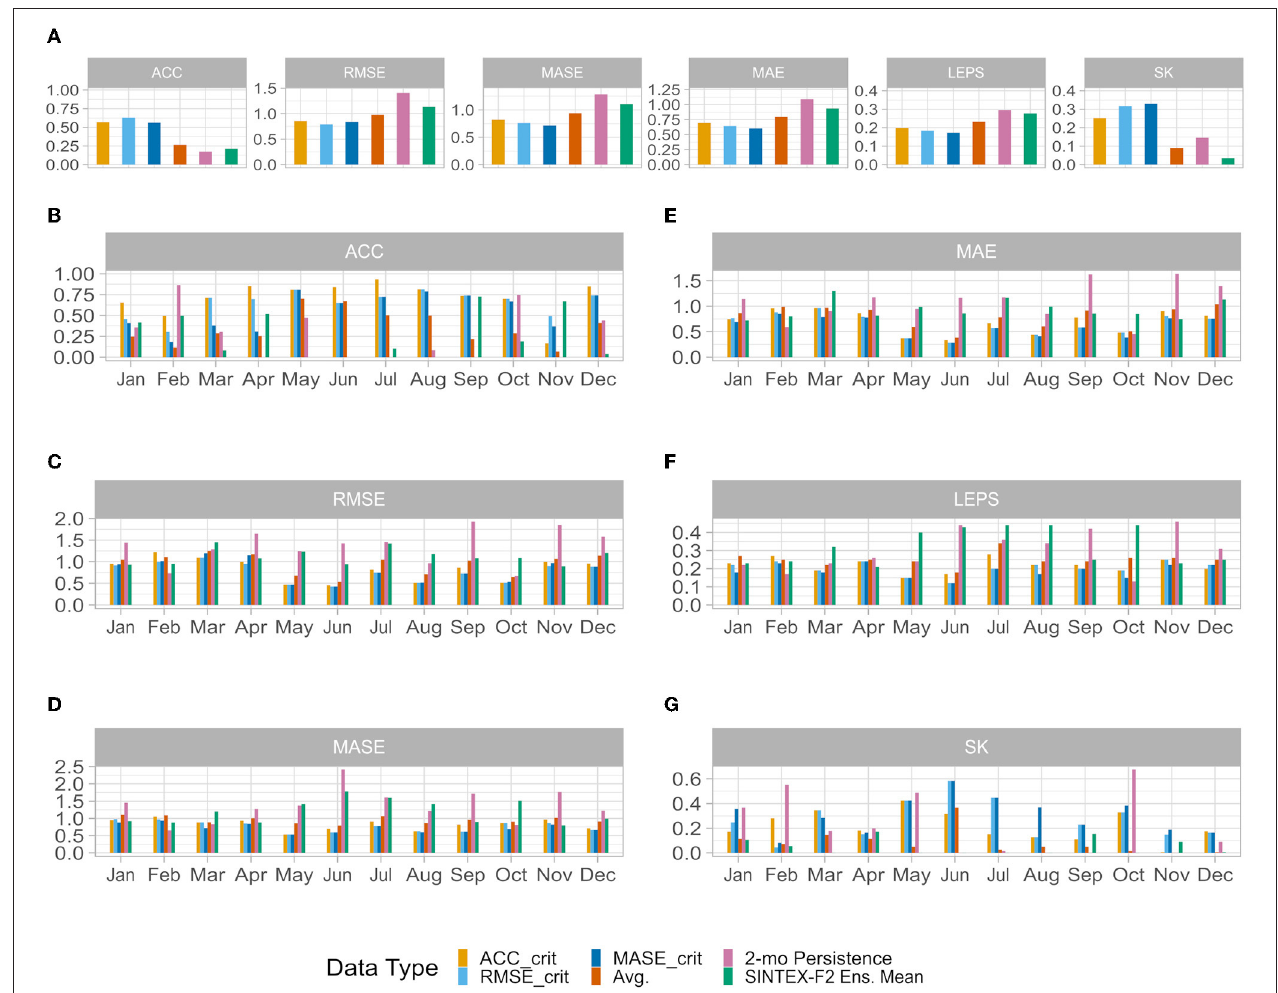
FIGURE 9 | Evaluation of the different prediction systems performance including the 2-month persistence (pink) and SINTEX-F2 (lime green). (A) Overall performance over the complete validation period, showing the anomaly correlation coefficient (ACC), root mean square error (RMSE), mean absolute scaled error (MASE), mean absolute error (MAE), linear error in probability space (LEPS), and skill error (SK). (B–F) Individual monthly performance metrics. Monthly performance according to (B) ACC, (C) RMSE, (D) MASE, (E) MAE, (F) LEPS, and (G)